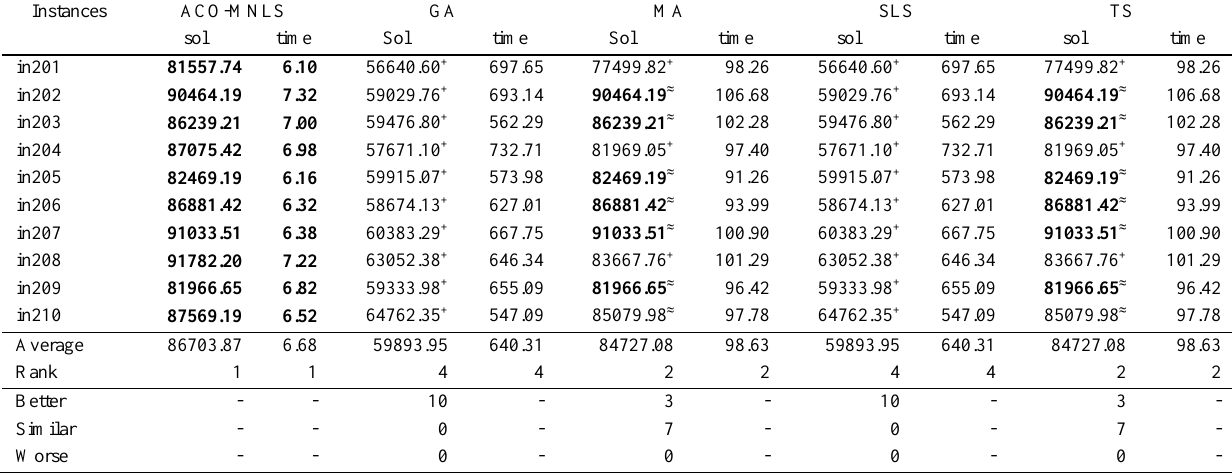
Table 3. Experimental results of proposed ACO-MNLS, GA, MA, SLS, and TS on some instances of REL-1000-1000.